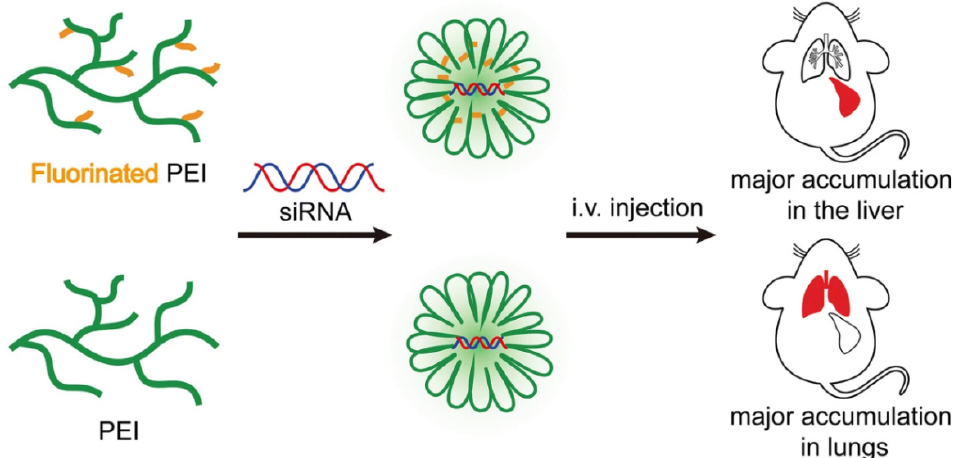
Figure 4. Fluorination of branched PEI (Mw = 25,000 g/mol) altered the biodistribution of siRNA from the lungs to the liver after intravenous administration of siRNA polyplexes to mice. Reprinted with permission from Ref. [143]. 2020, Springer Nature.